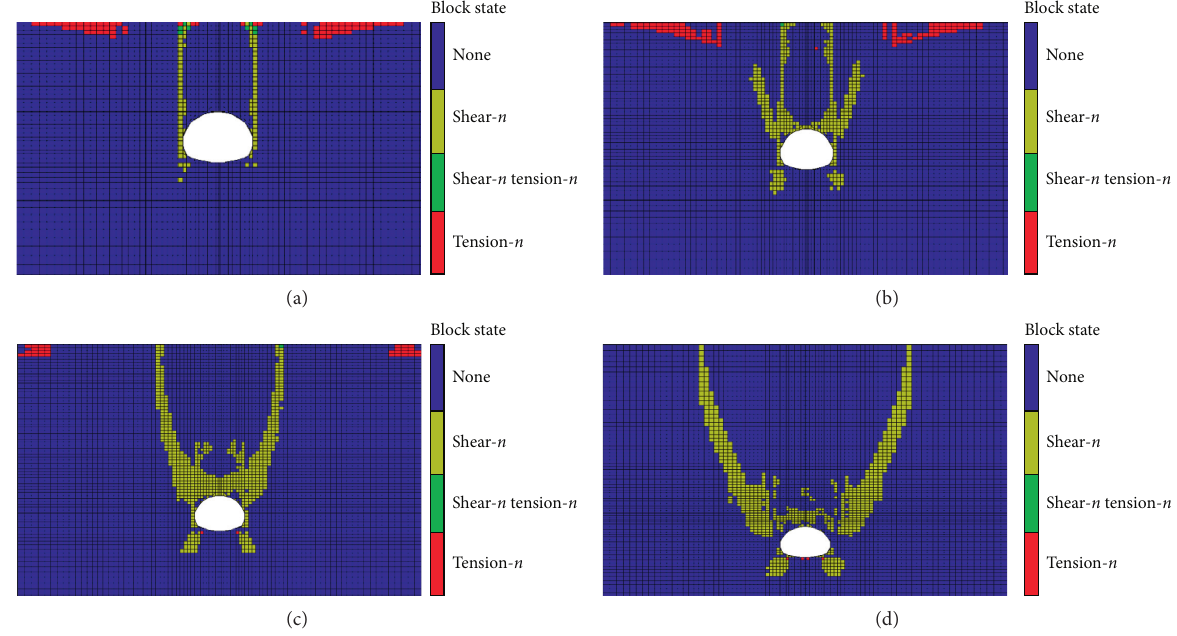
Figure 24: Distribution of plastic zone after tunnel excavation. (a) depth: 20m, (b) depth: 30m, (c) depth: 40m, and (d) depth: 50m.